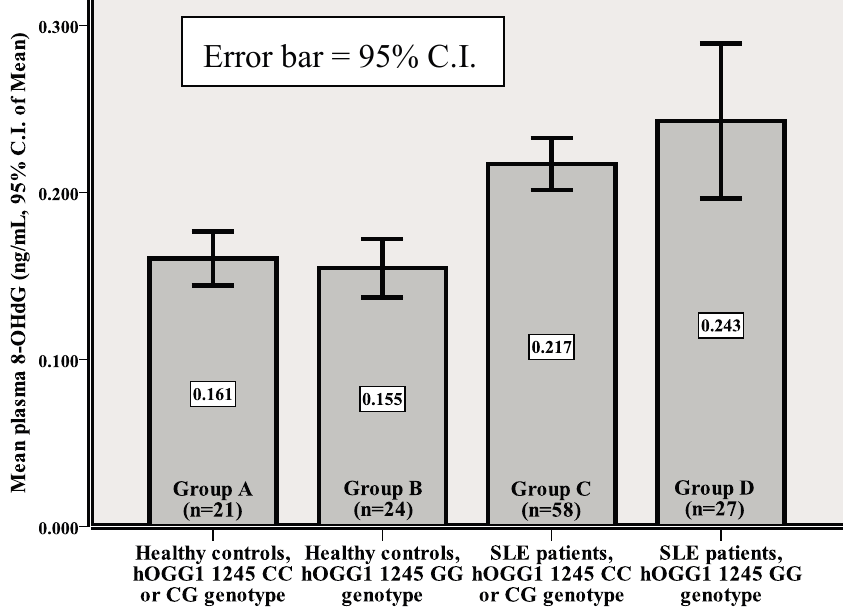
Figure 2. The plasma 8-OHdG in healthy controls and SLE patients with different hOGG1 gene polymorphisms (mean levels and 95%